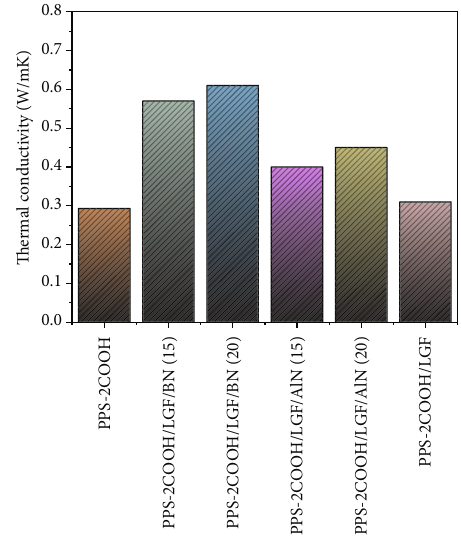
Figure 5: E ff ect of di ff erent fi llers on λ of PPS-2COOH, PPS- 2COOH/LGF/BN, and